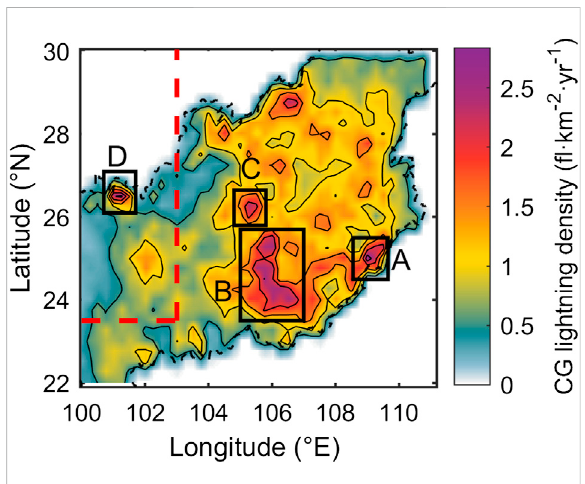
FIGURE 2 The spatial distributionof annual average lightning density on the Yungui Plateau from 2016 to 2020. The red dotted line is the dividing line of dry and humid regions in China. The regions with high lightning density are marked with black